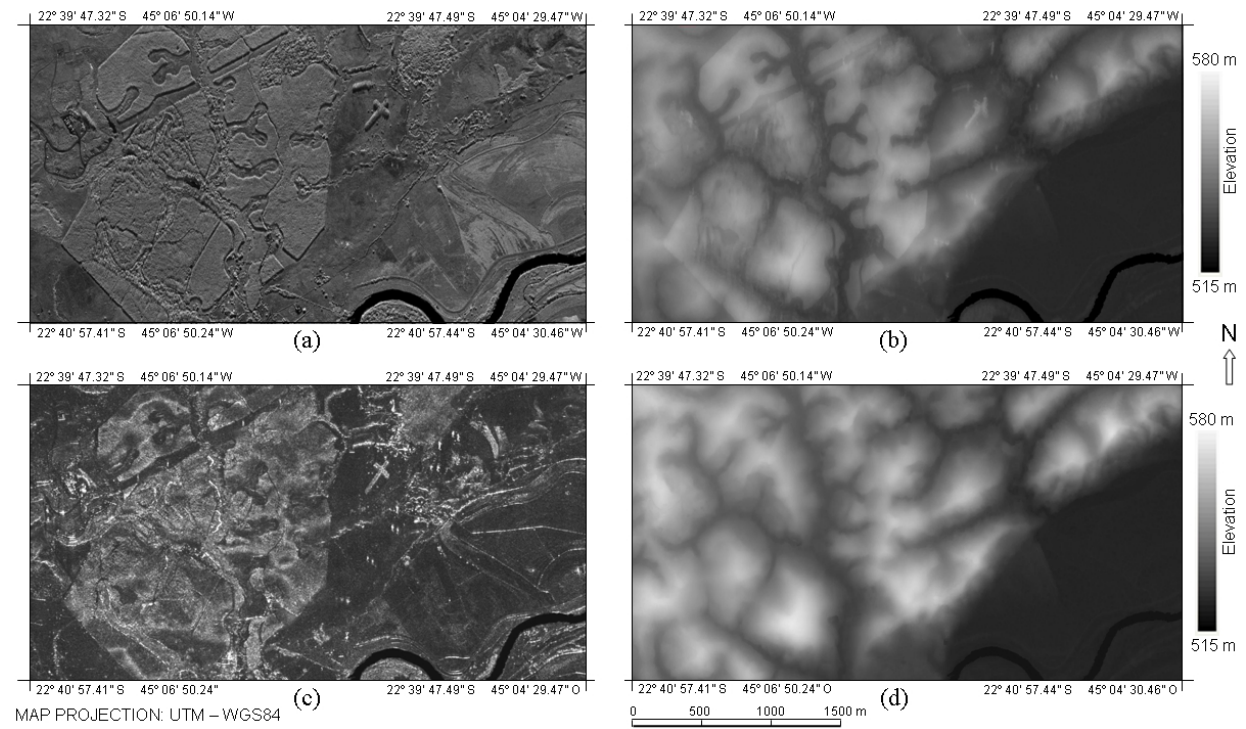
Figure 10. OrbiSAR-1 data: ( a ) Geocoded X-band image, ( b ) X-band DEM, ( c ) Geocoded P-band image, ( d ) P-band